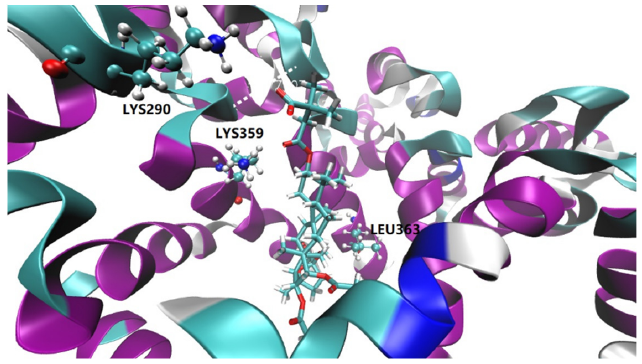
Figure 6. Variations of RMSD values in MD simulations of BVM and DSC.